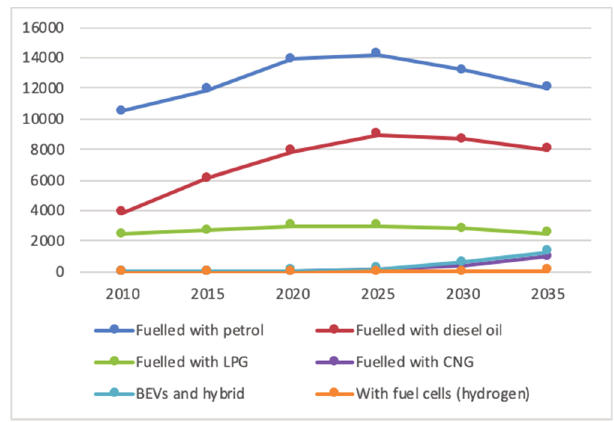
Fig. 1. Forecasted number of passenger cars in Poland up to year 2035 by types of energy carriers [in thousands]